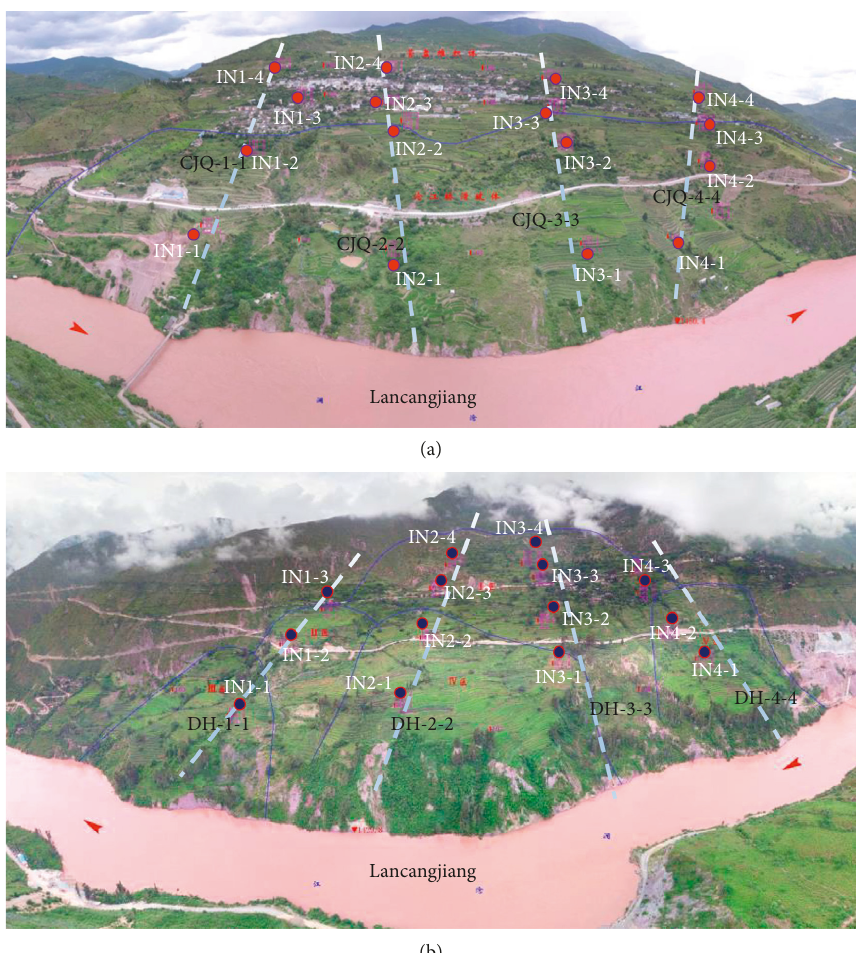
Figure 3: Schematic diagram of monitoring plan for Cangjiangqiao and Dahua landslides. (a) Cangjiangqiao landslide (left bank). (b) Dahua landslide (right